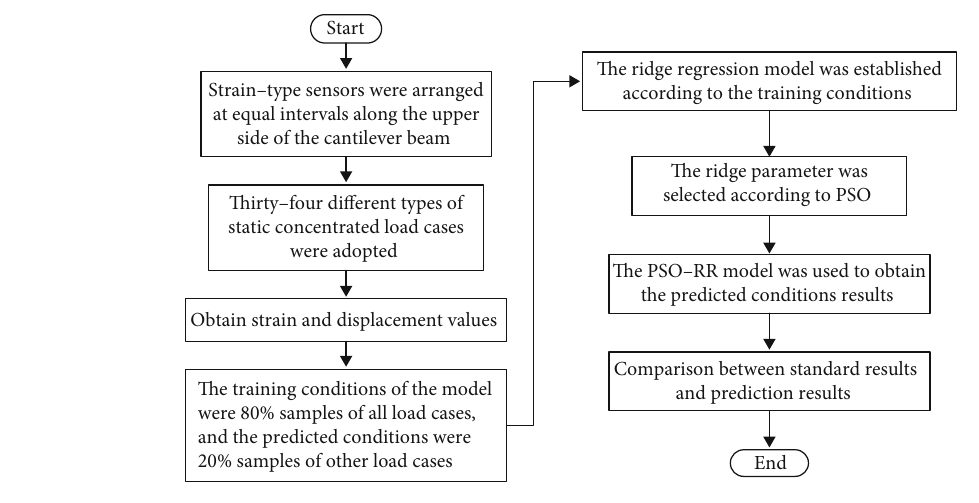
Figure 7: Flow chart of